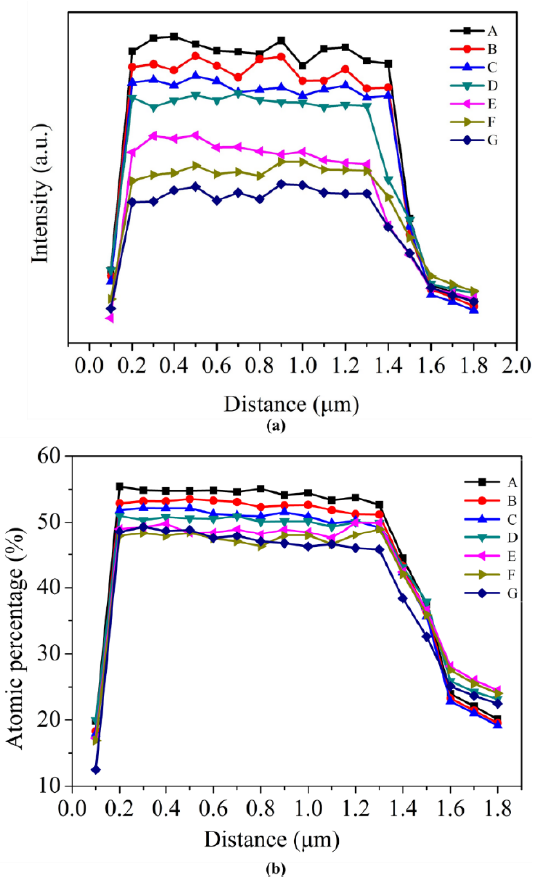
Figure 9. XPS-spectra of the present specimen A – G, revealing ( a ) O1 s binding energy in each layer of Ti-6Al-4V after various polishing. ( b ) Oxygen atomic percentage in each layer of Ti-6Al-4V